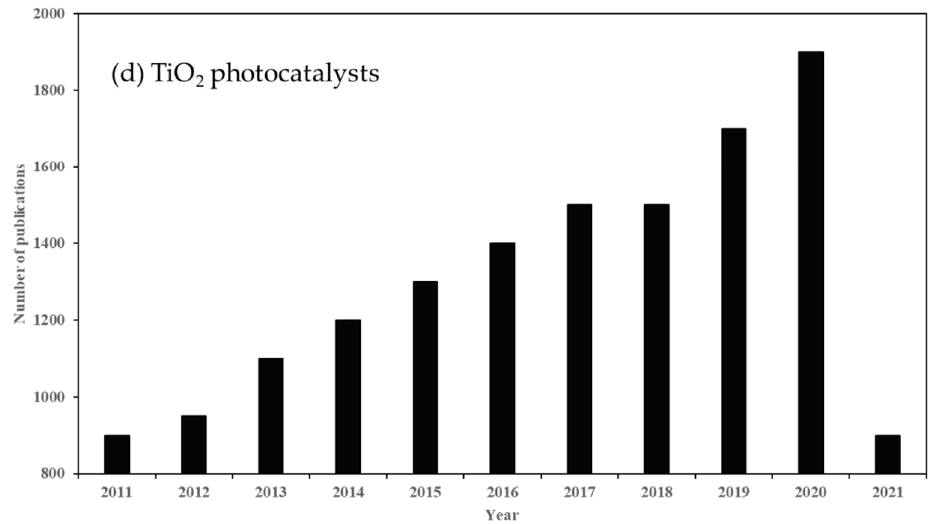
Figure 1. Publication trend of ( a ) membranes, ( b ) advanced oxidation processes (AOP), ( c ) integrated photocatalytic processes (IPM), and ( d ) TiO 2 photocatalysts, from 2011–2021 (Web of Science database, 20 April 2021).